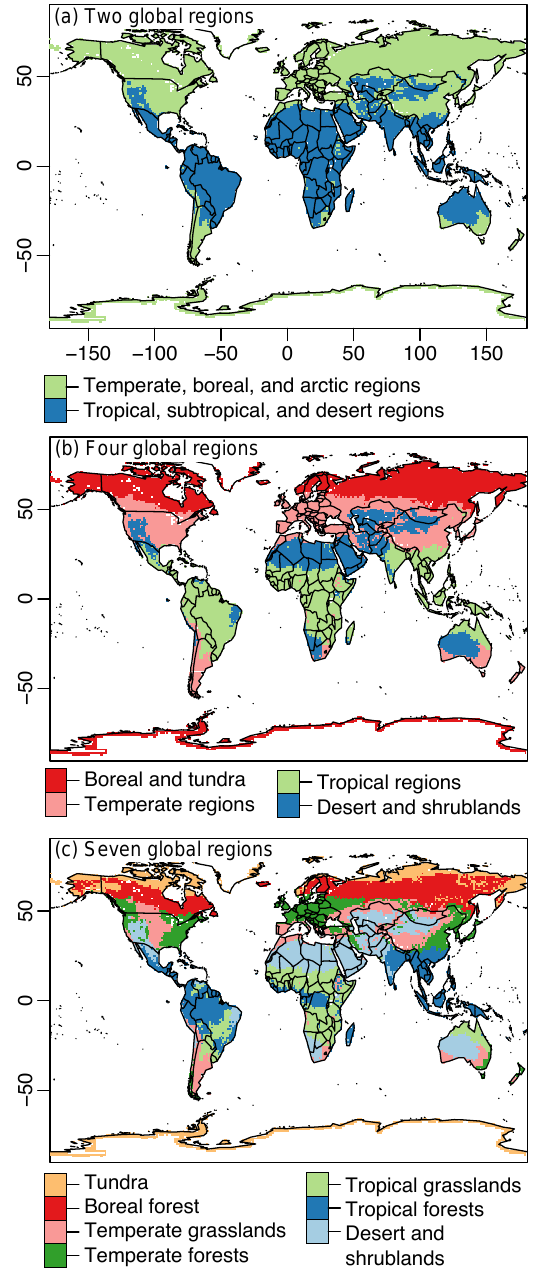
Figure 2. The two hemispheric regions (a) , four continental regions (b) , and seven biomes (c) used in this study. The biomes are based on a world biome map by Olson et al. (2001). The two and four region maps are amalgamated versions of the